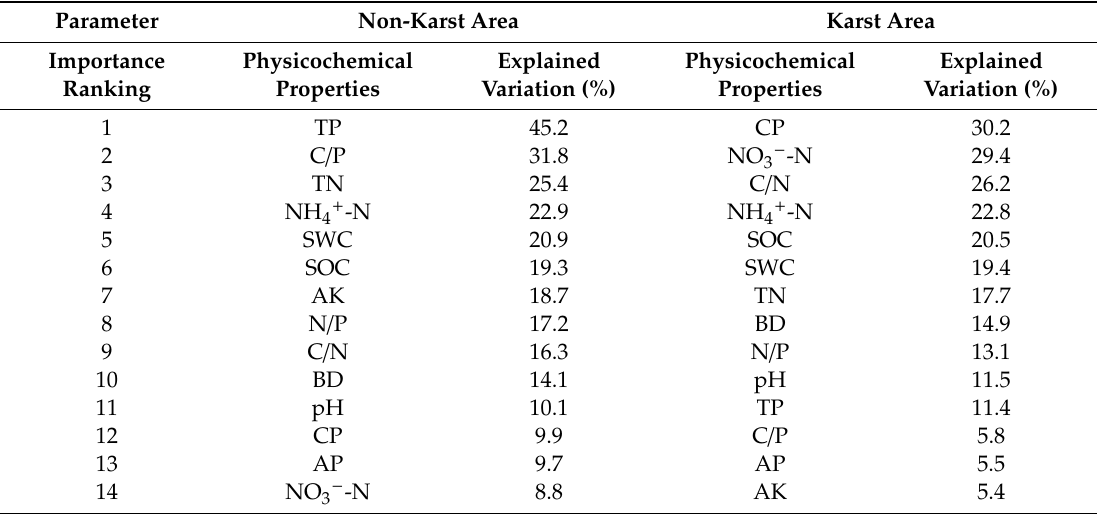
Table 5. Importance order of the explanation of the physical and chemical factor variation. Parameter Non-Karst Area Karst Area Importance Physicochemical Explained Physicochemical Explained Ranking Properties Variation (%) Properties Variation